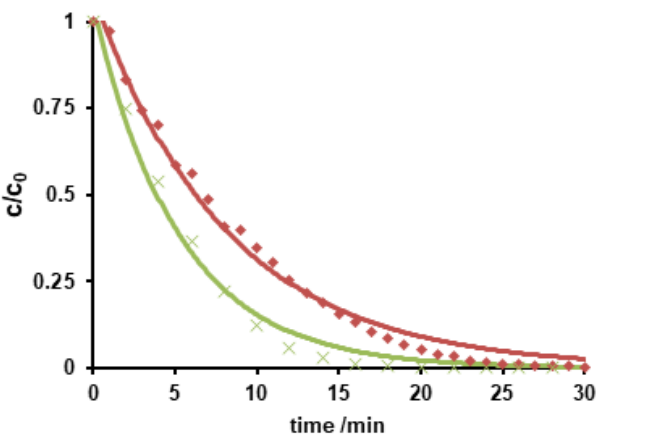
Figure 3. Normalized c-t -curves of ozonation of metoprolol using ozone-flow (red, ♦ ) and in ozone-saturated solution (green, ■ ).